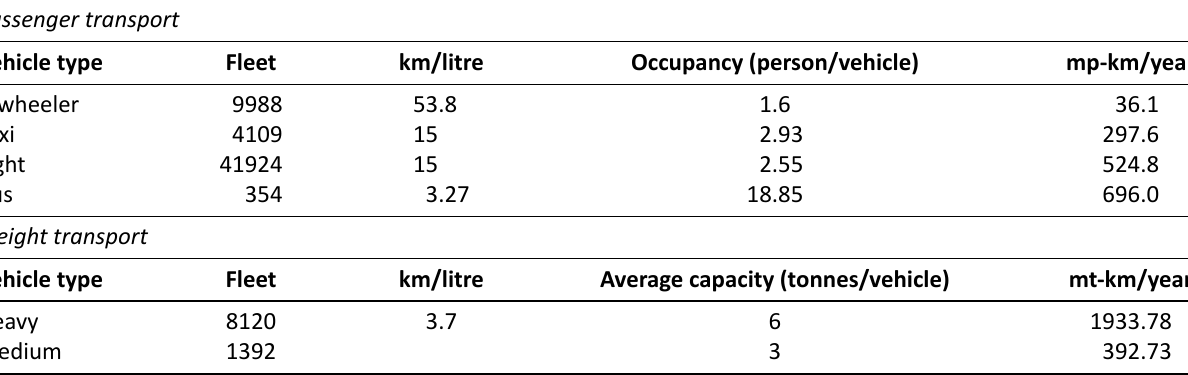
Table A8. Transport sector technology characteristics, based on DoE (2010), Ministry of Information and Communications (2015), Yangka and Diesendorf (2016) and Zhu et al.